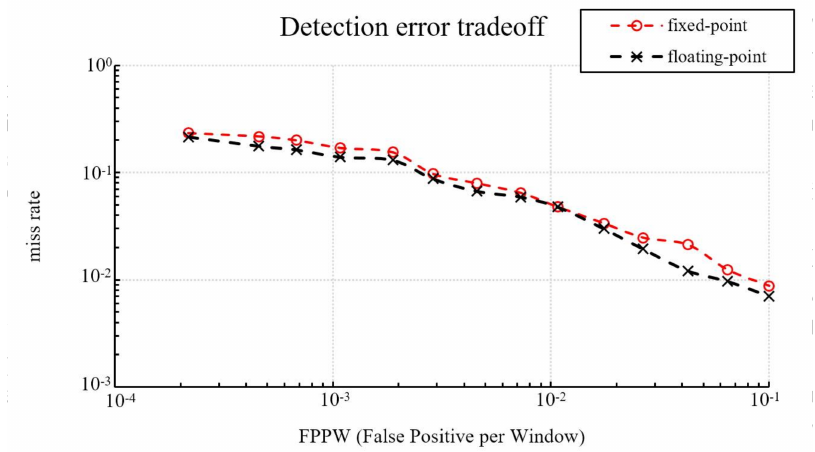
Figure 9. Detection accuracy of fixed-point and floating-point implementations on the INRIA person